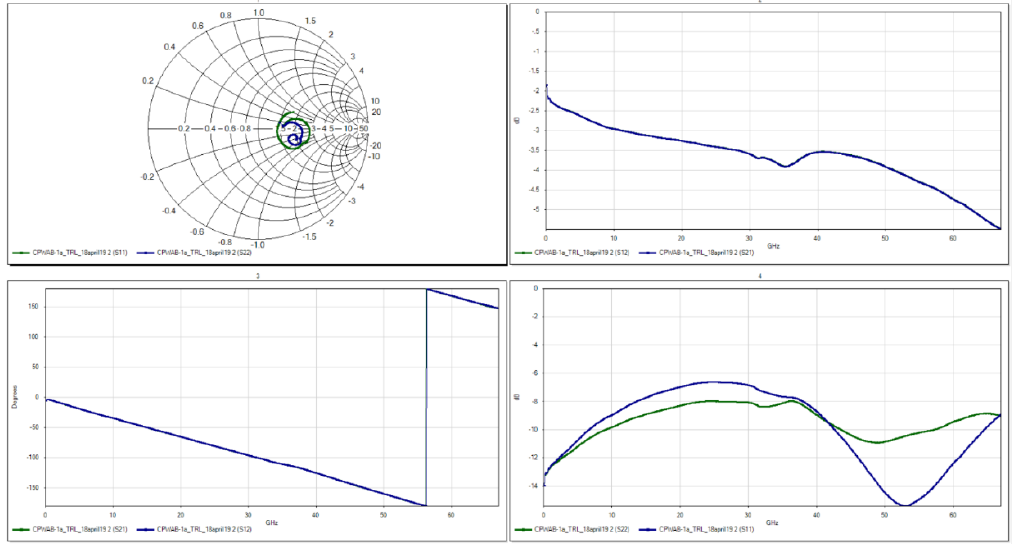
Figure 2. Measured S-parameter frequency responses for the CPW line of the airbrushed HPS-FG77 on ABS cured at 110 C.